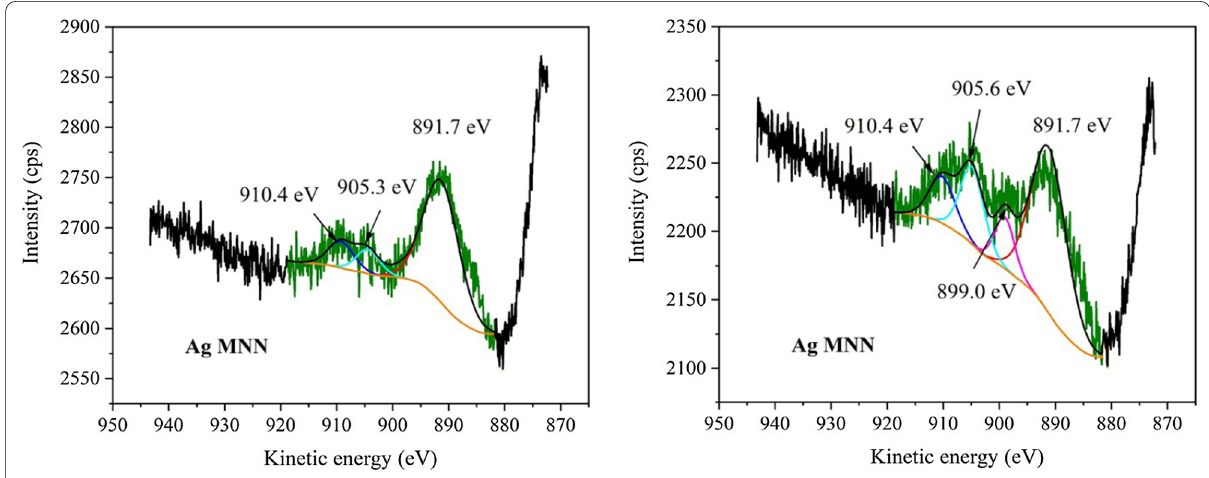
Fig. 7 XPS spectra of Auger line Ag MNN of Ag + CNE2 (left) and AgCNE4 (right)